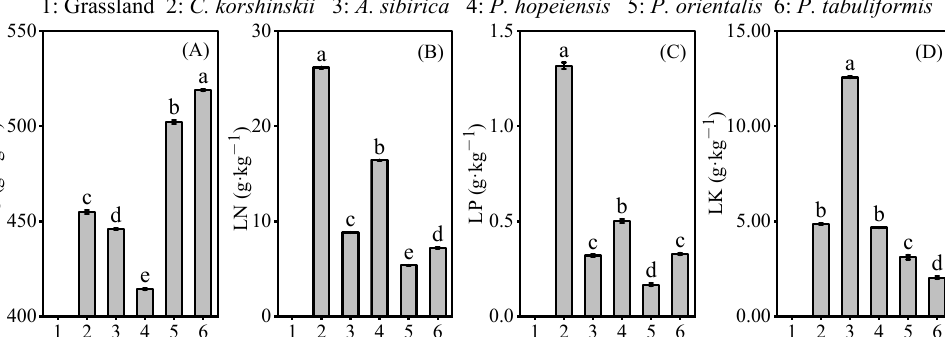
Figure 3. Comparison of the soil enzyme activities of different vegetation types. SC, sucrase; UE, urease; ALP, alkaline phosphatase. Different lowercases indicate significant differences among the six vegetation types ( p < 0.05).